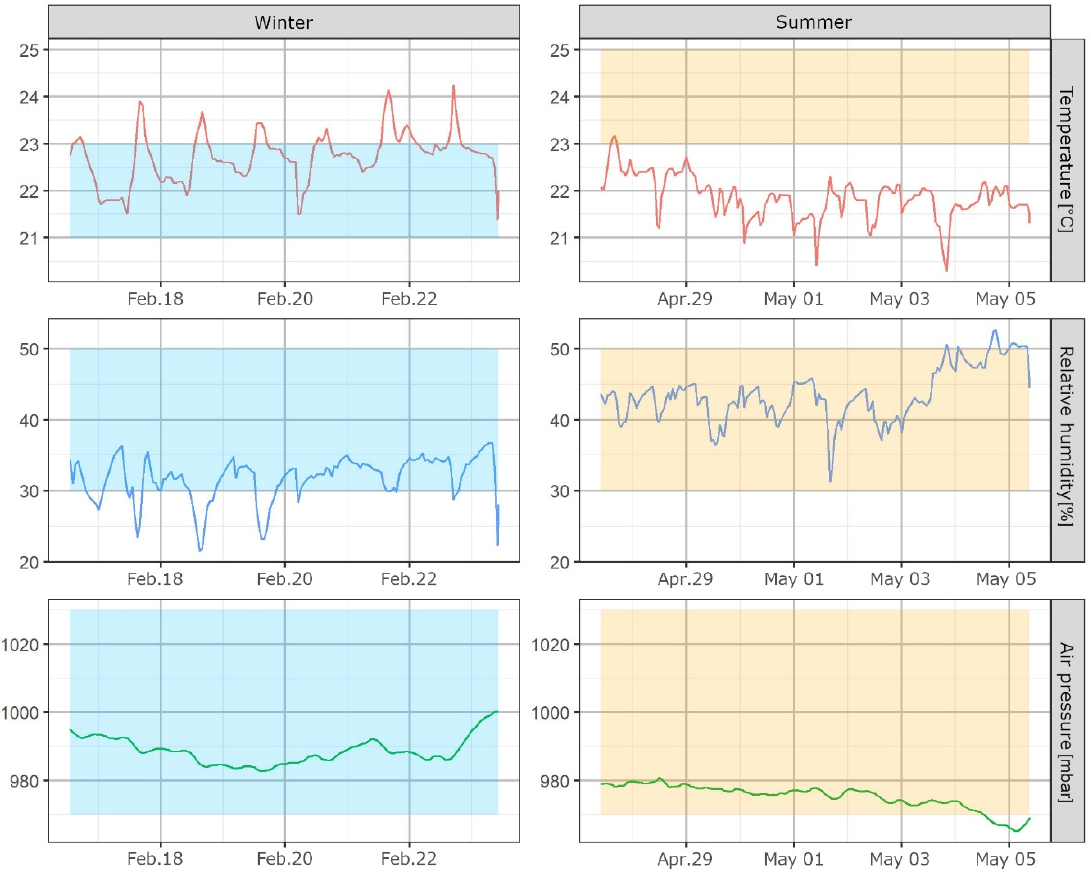
Figure 2. Faceted plots with meteorological variables—temperature, relative humidity, and air pressure; data from IAQ. Colored horizontal ribbons represent “optimal” values for each variable.